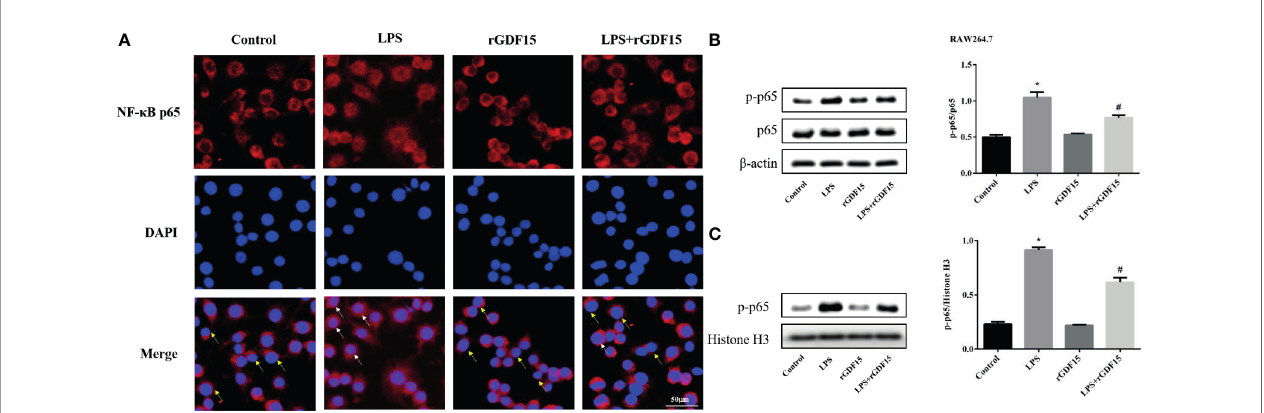
FIGURE 15 | Nuclear translocation of NF- k B p65 in RAW264.7 cells pretreated with rGDF15 in in fl ammatory state was detected by immuno fl uorescence (A) . Scale bar = 50 m m. Red fl uorescence marked NF- k B p65 and blue fl uorescence marked nucleus. Yellow arrows indicated nuclear translocation negative cells; white arrows indicated nuclear translocation positive cells. The NF- k B p65 phosphorylation level of RAW264.7 cells pretreated with rGDF15 in in fl ammatory state was detected by Western blot (B) . The expression of p-p65 in the nucleus was detected by Western blot (C) . * P < 0.05, compare with the control group; # P < 0.05, compare with the LPS